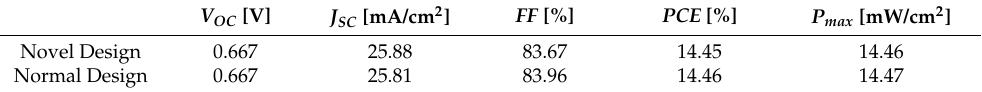
Figure 4. The energy band diagram at V OC for ( a ) the normal design and ( b ) the novel design. The insets show a zoomed-in depth to investigate the behavior of the quasi-Fermi levels before and after applying the RCL. Table 2. Comparison between the PV parameters of the initial novel design and the normal structure.